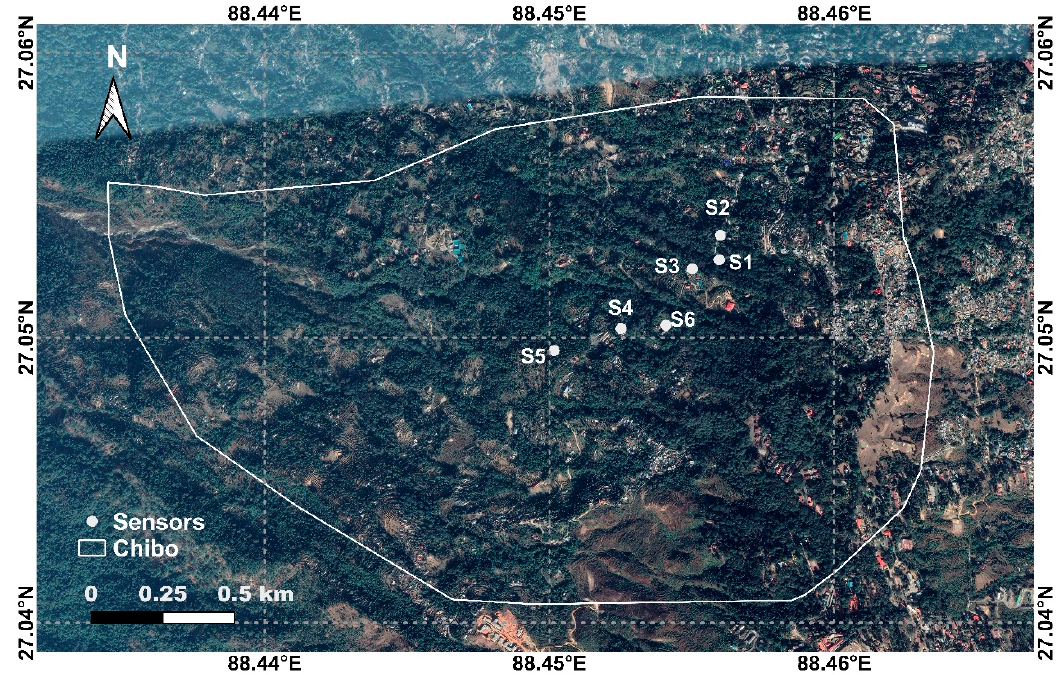
Figure 2. Location of tilt sensors installed in Chibo.